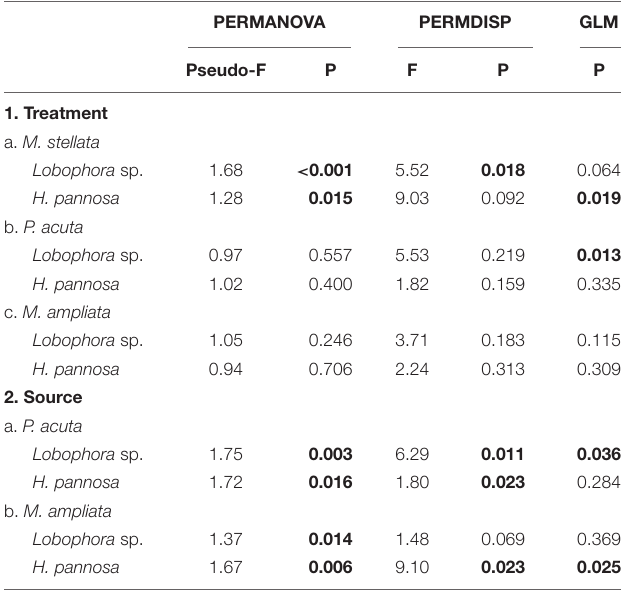
The first set shows the differences in the coral microbiome by algal treatment (i.e., direct algal contact, close proximity to alga, algal mimic, control) for each coral and algal species. The second set shows the differences in the coral microbiome by the source reef of the coral colony for each coral and algal species. Bold values denote statistical significance when α =